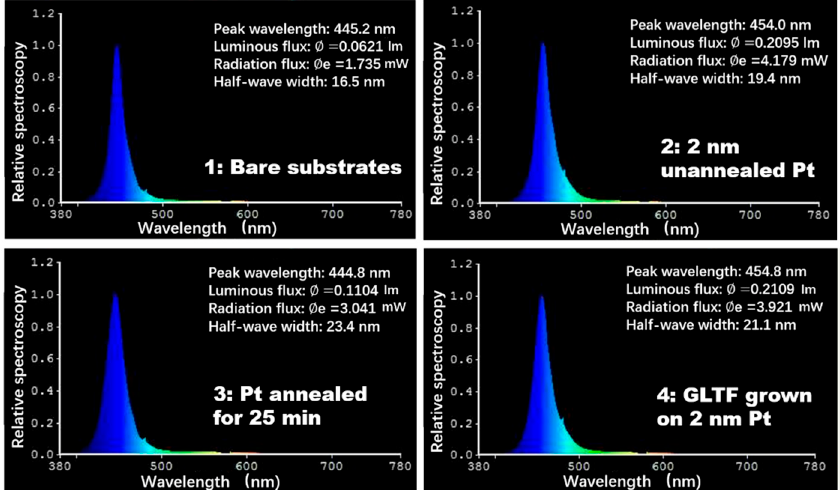
Figure 6. Electroluminescence spectra of GaN LED samples 1–4 measured at 20 mA injection current.